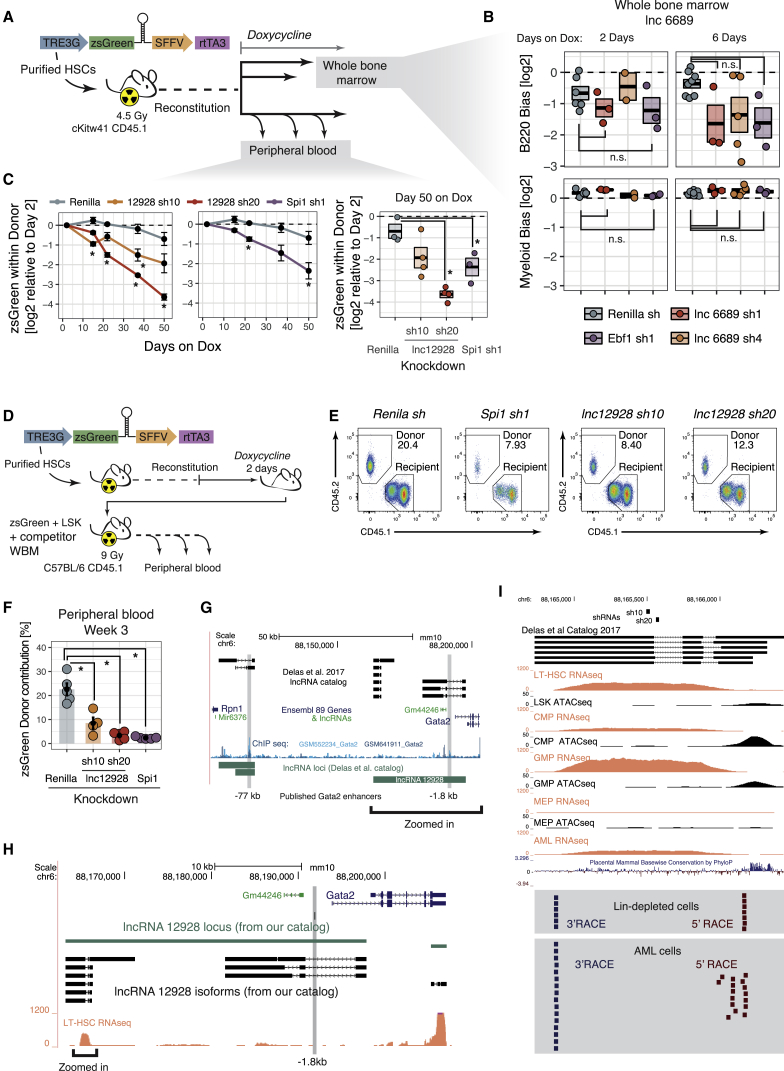
lnc6689 Knockdown Results in B Cell Depletion and Myeloid Enrichment, while lnc12928 Is Required for Multilineage Differentiation(A) Schematic representation of the vector used and the experimental design for bone marrow transplants using inducible shRNAs.(B) Lineage-bias values for the B and myeloid lineages in the bone marrow for the knockdowns indicated in animals induced with doxycycline for 2 or 6 days. The center of the box indicates average and the box edges represent SEM.(C) Proportion of zsGreen+ cells within donor peripheral blood relative to 2 days post-administration of doxycycline for each shRNA over time (left [days on dox], average and SEM presented for each time point). For the last time point (50 days), the values for each animal are represented (right). The center of the box indicates average and the box edges represent SEM. ∗p < 0.05; Welch’s unequal variances t test.(D) Schematic representation of the vector used and the experimental design for re-transplantations.(E) Representative flow cytometry plots of the peripheral blood of animals transplanted solely with zsGreen+ LSK, as described in (D), for each of the conditions analyzed.(F) zsGreen donor percentage for each re-transplanted animal at 3 weeks post-transplant. The bar heights indicate the average zsGreen percentage per condition; the error bars represent SEMs. ∗p < 0.05; Welch’s unequal variances t test.(G) Genome browser representation of the predicted lnc12928 locus and its neighboring genes Gata2 and Rpn1. The location of the published Gata2 enhancers is indicated. Gata2 chromatin immunoprecipitation sequencing (ChIP-seq) tracks are displayed as obtained from codex.stemcells.cam.ac.uk.(H) Magnified region as indicated in (G), showing the RNA-seq coverage for long-term HSC (LT-HSC).(I) Magnified region as indicated in (H), showing the transcript starts and ends, as defined by 5′/3′ RACE. The RNA-seq coverage is presented for the cell types indicated. The assay for transposase accessible chromatin with high-throughput sequencing (ATAC-seq) came from Lara-Astiaso et al. (2014). The location of the shRNAs used against this lncRNA are also presented. Lin, lineage.See also Figure S3.